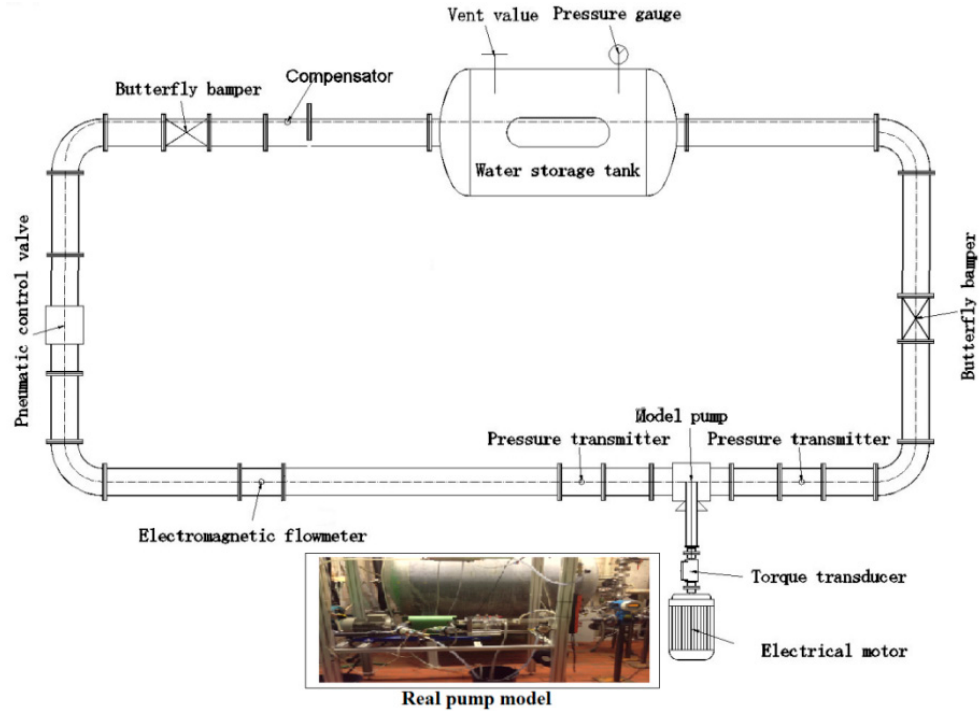
Figure 13. Experimental setup.